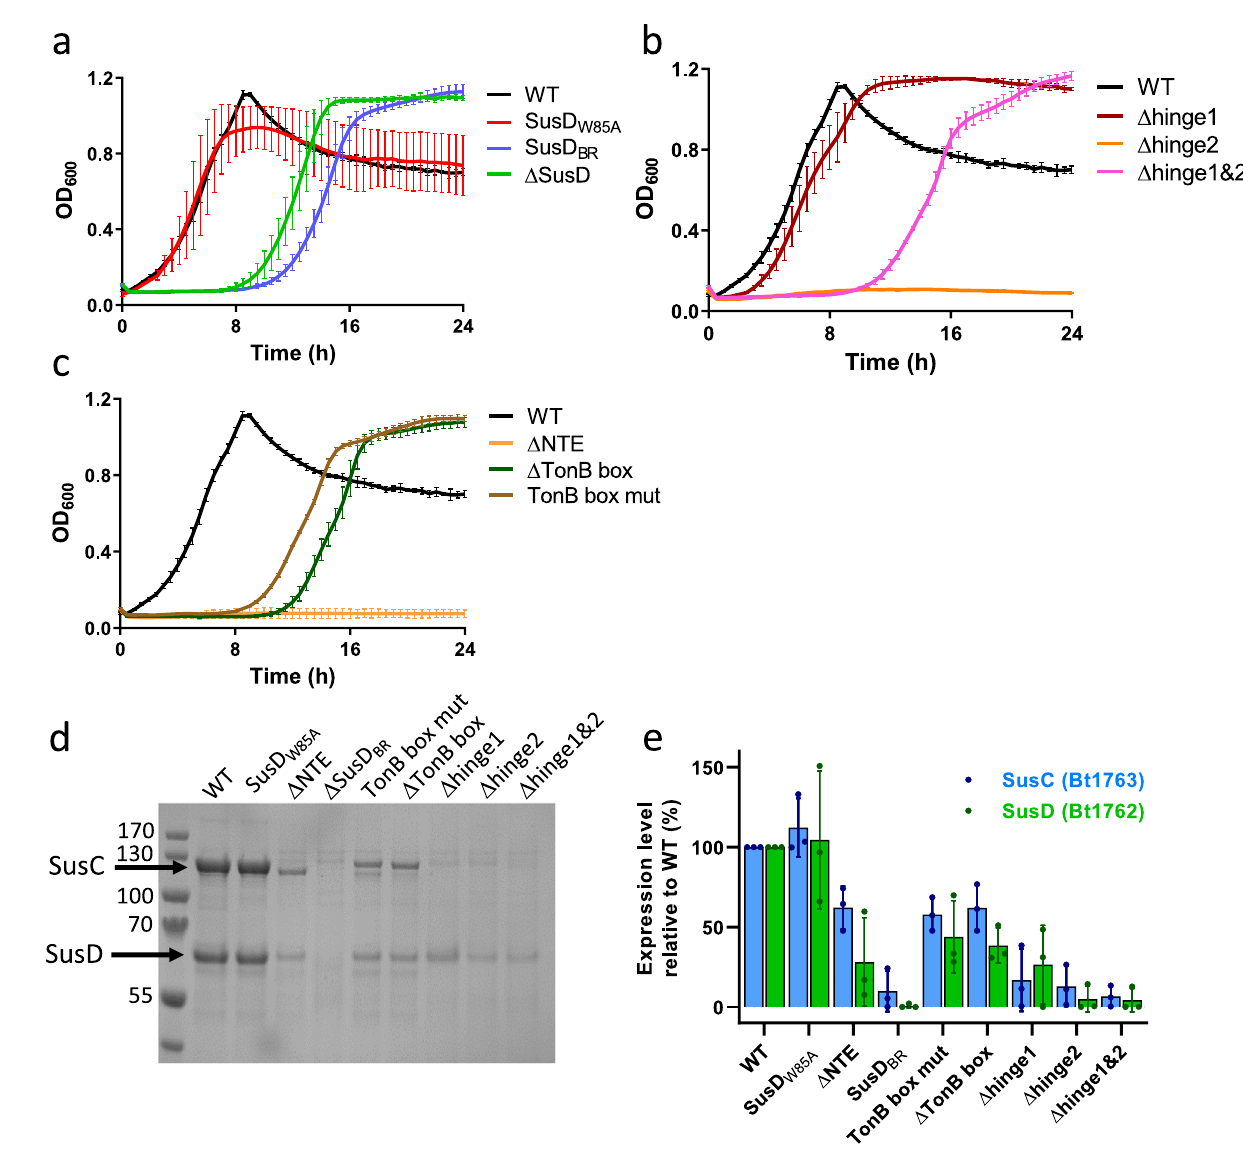
Fig. 4 Structure – function studies of the Bt1762-63 SusCD levan importer. a – c Growth curves on levan of Bt1762 SusD mutant strains ( a ), Bt1763 SusC hinge loop mutant strains ( b ), and Bt1763 Δ NTE and TonB box mutant strains ( c ). WT wild-type strain (with His6 tag on C terminus of Bt1762). Growth curves show mean (solid line) ± SD of triplicate wells and are representative of three independent experiments. d Representative SDS-PAGE gel ( n = 3 independent experiments) of IMAC-puri fi ed Bt1762-63 complexes from OM fractions of WT (Bt1762-his strain) and mutant strains grown on MM fructose. The far left lane is MW marker with the sizes shown in kDa. e Relative expression levels quanti fi ed from band intensities on SDS-PAGE gels using ImageJ ( n = 3 independent experiments; means ± SD are shown, plus individual values). Band intensities of WT Bt1762 and Bt1763 were set to 100%. Source data are provided as a Source Data fi